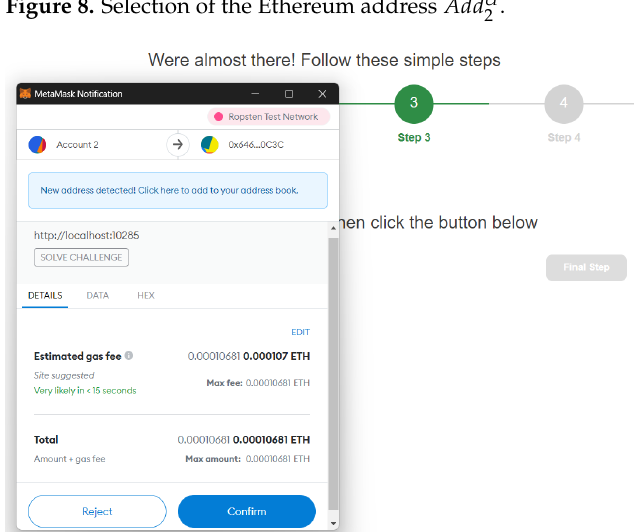
Figure 8. Selection of the Ethereum address Add U